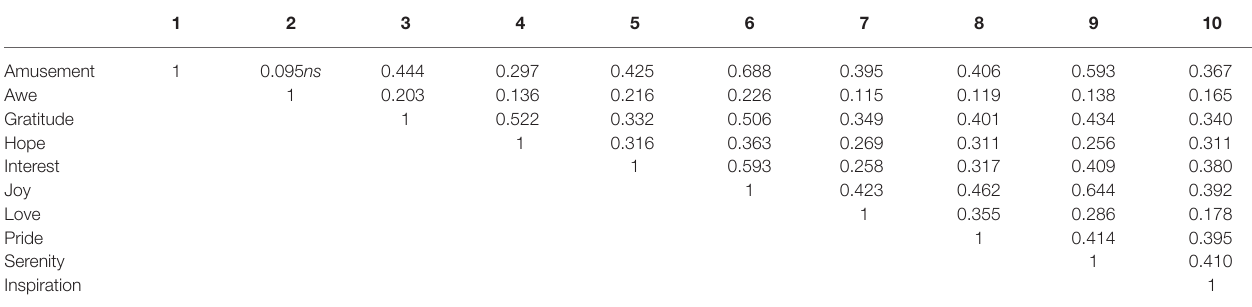
TABLE 1 | Correlations of measured